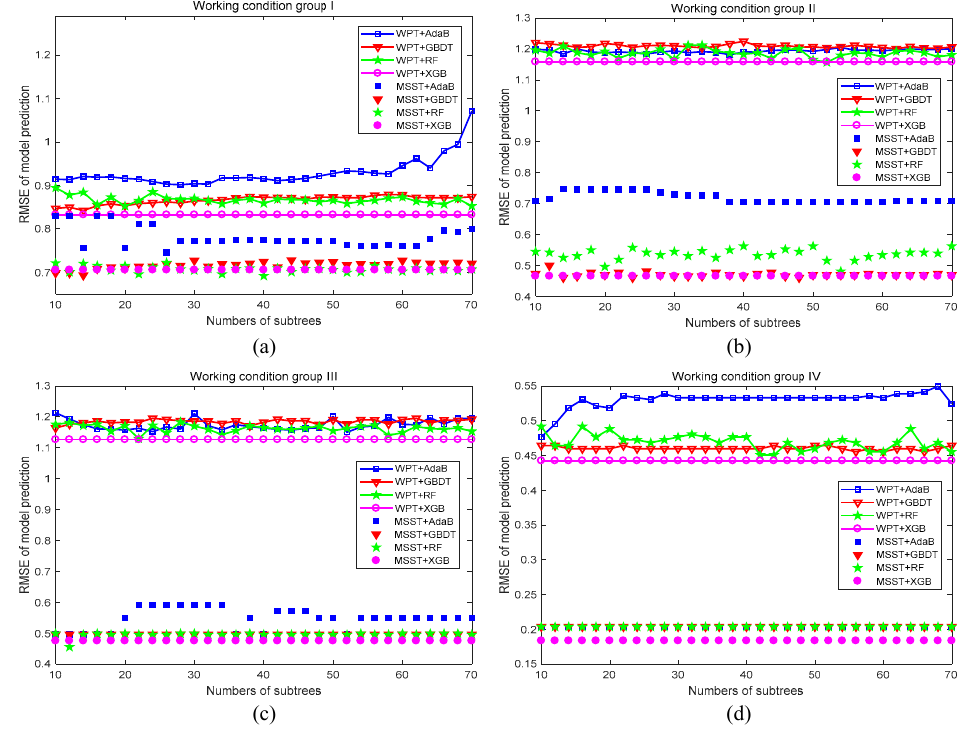
Figure 10. Root mean squared error (RMSE) values obtained under different evaluation approaches: ( a ) Working condition group I; ( b ) Working condition group II; ( c ) Working condition group III; ( d ) Working condition group IV.